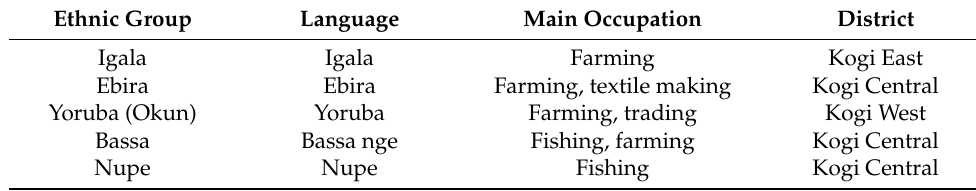
Table 3. Characteristics of the main ethnic groups in Kogi state (source;